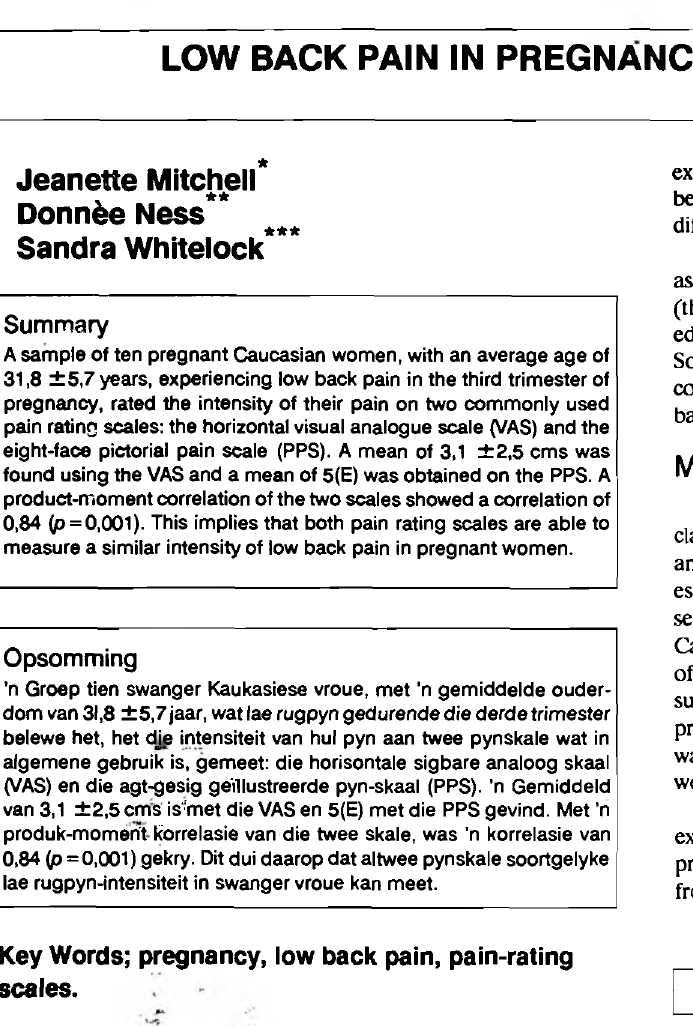
FIG 1: THE VISUAL ANALOGUE SCALE